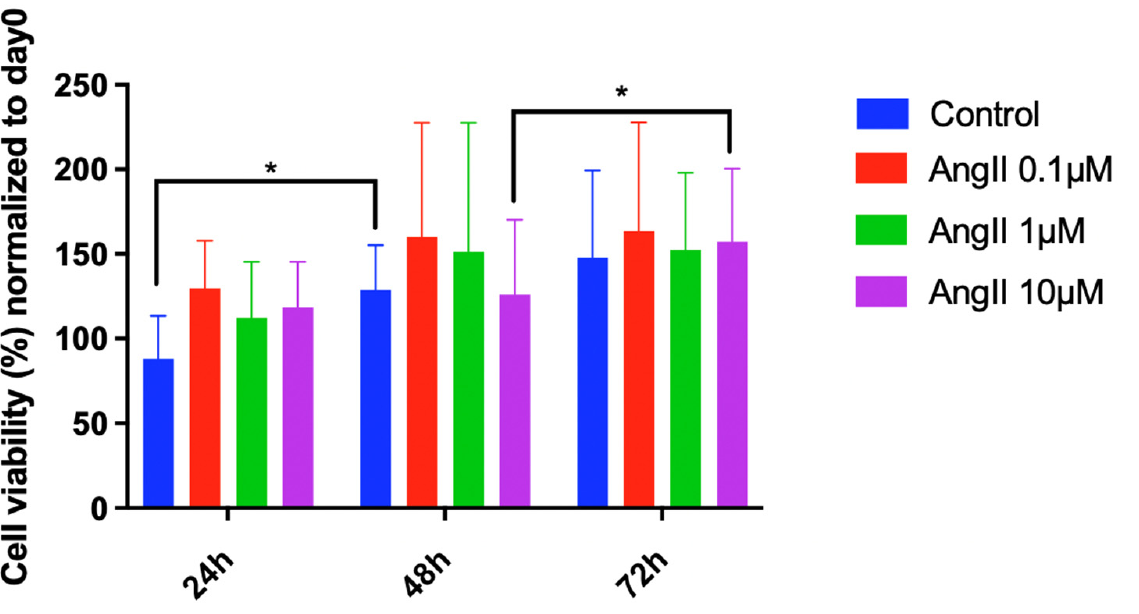
Figure 2. Cell metabolic activity analysis in human NP cells treated with angiotensin II (0.1 μ M–10 μ M) after 24 h, 48 h, and 72 h of exposure. Cell metabolic activity normalized to the baseline (day 0/beginning of drug exposure) is shown. n = 2 biological replicates and n = 3 technical replicates per donor were assessed. * p <